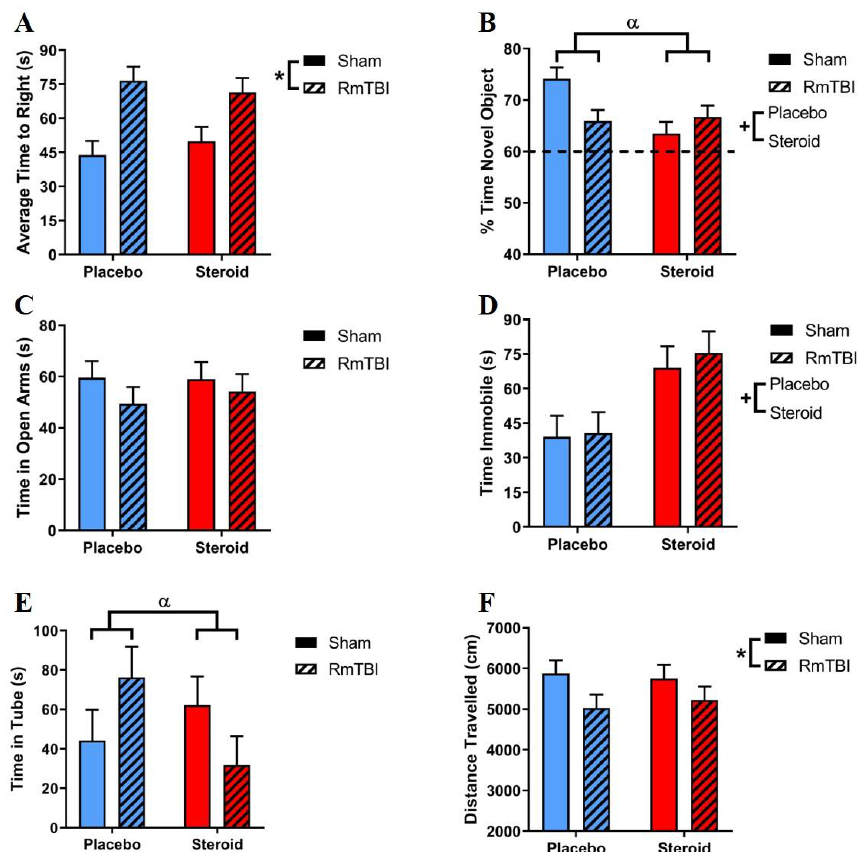
Figure 3. Bar graphs displaying outcomes from a behavioural test battery for all groups. Means ± standard error are displayed, where (*) indicates a main effect of RmTBI, (+) indicates a main effect of Met treatment, and (α) indicates a significant Met treatment by RmTBI interaction; p ≤ 0.05. ( A ) displays the average time-to-right after sham injury or RmTBI; main effect of RmTBI, whereby injured animals had increased time-to-right. ( B ) displays the % of time spent with a novel object in the NCM task; main effect of steroid treatment decreasing time spent with the novel object; significant RmTBI by steroid treatment interaction, where Met exposure in sham animals significantly decreased performance. The hatched line indicates the % of expected time the rat will spend investigating the novel object. ( C ) displays the average time spent in the open arms of the elevated plus maze; no main effects of steroid treatment or RmTBI. ( D ) displays the mean time spent immobile in the forced swim test; main effect of steroid treatment, whereby animals in the steroid groups spent significantly more time immobile than placebo groups. ( E ) displays the average time spent in the tube over 3 trials in the dominance tube test; significant RmTBI by steroid treatment interaction driven by injured animals, where the steroid group had lower scores than the placebo group ( F ) displays the mean distance